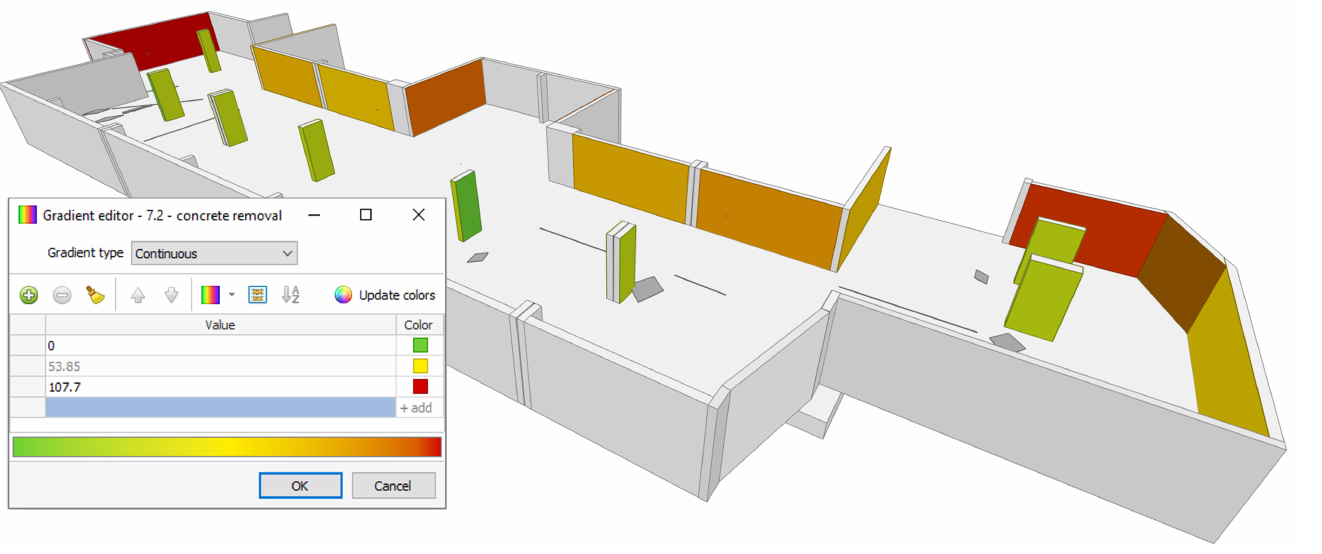
Figure 8. Required concrete removal in mm for method 7.2 color-coded for walls and